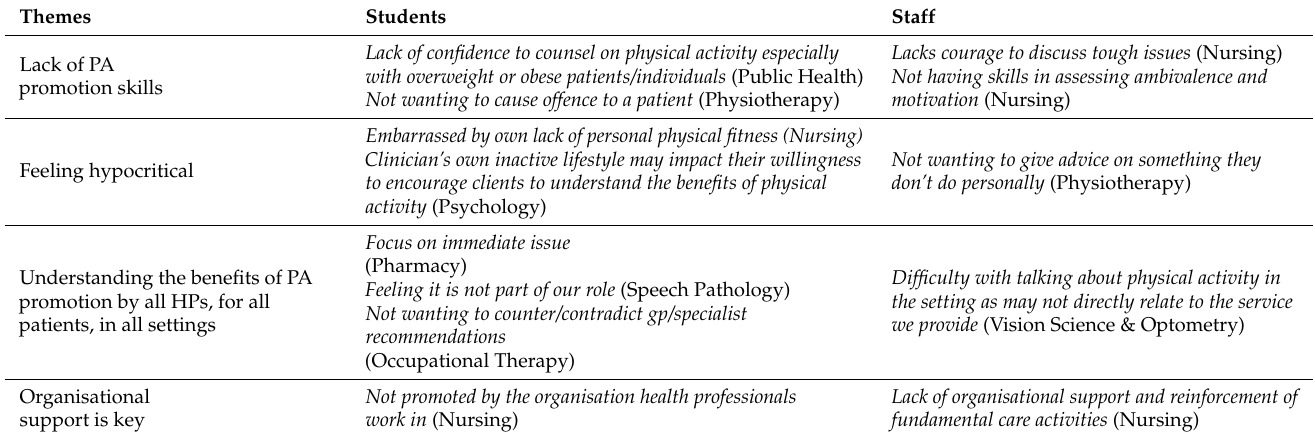
Table 3. Themes relating to barriers to the promotion of physical activity with supporting verbatim